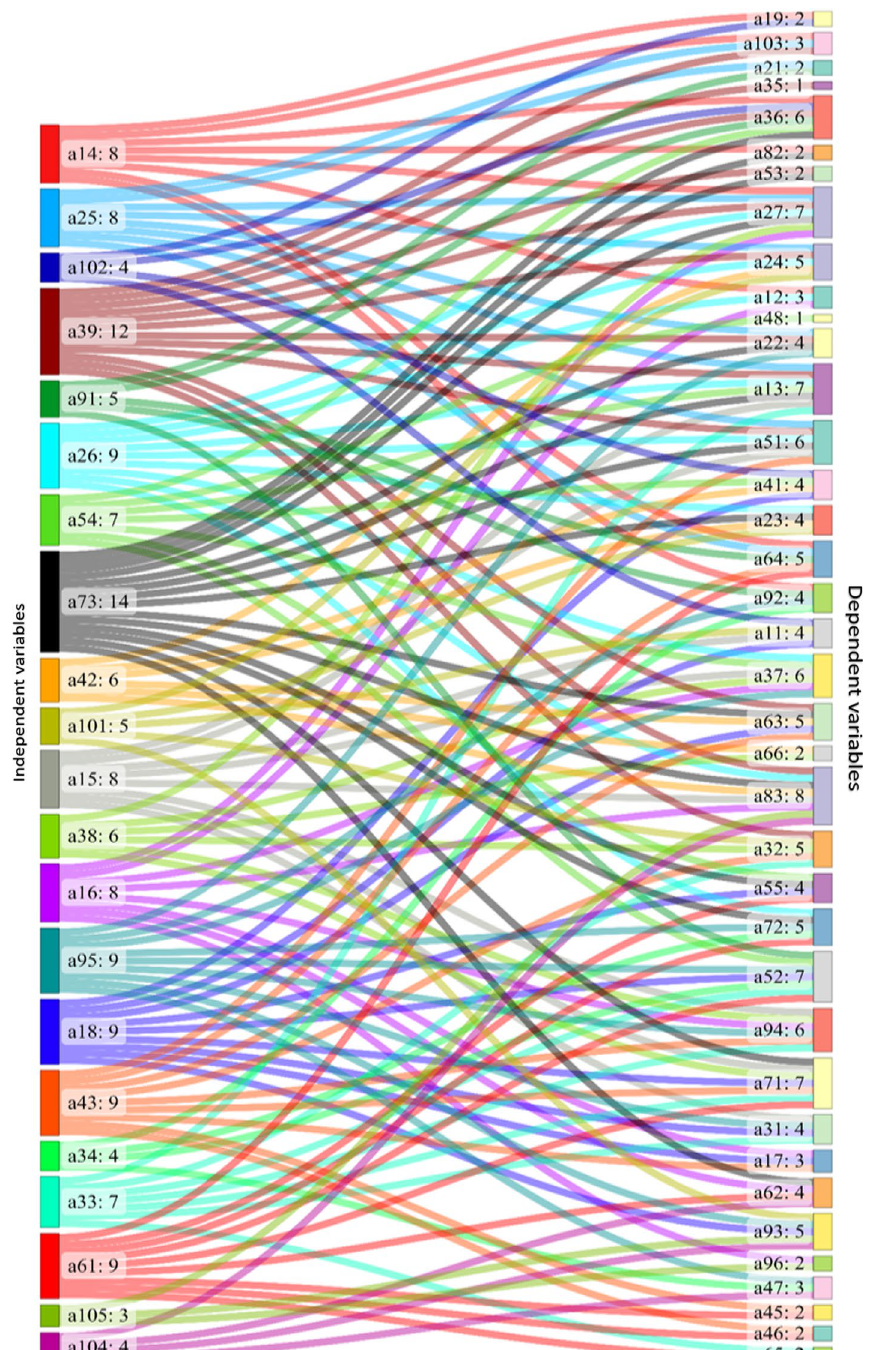
Fig. 5 The significant relationships among independent